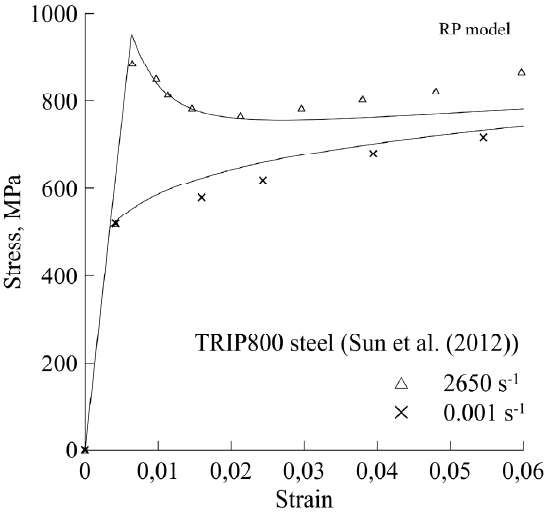
Fig. 5. Stress-strain dependences of TRIP800 steel (data from [5]) on strain rates 0.001 s –1 and 2650 s –1 , predicted by relaxation model of plasticity